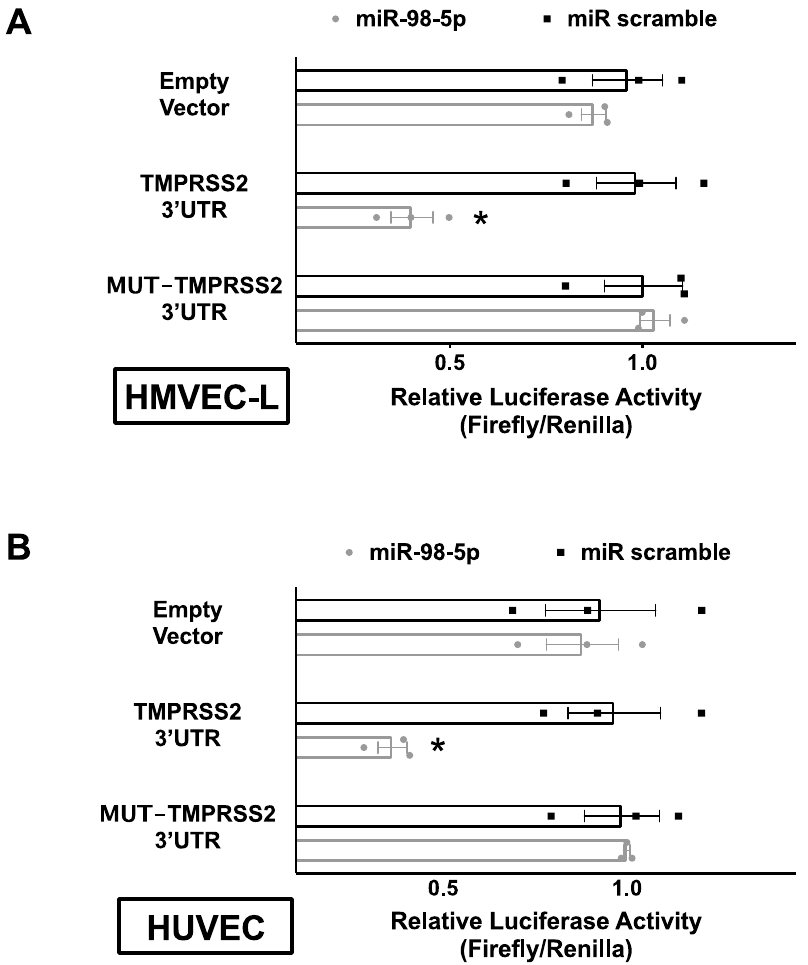
Figure 2. Validation of TMPRSS2 targeting by miR-98-5p. Luciferase activity was measured in adult human lung microvascular endothelial cells (HMVEC-L) ( A ) and human umbilical vein endothelial cells (HUVEC) ( B ) 48 h after transfection, using the vector without TMPRSS2 3 ′ -UTR (empty vector), the vector containing the wild-type TMPRSS2 3 ′ -UTR, and the vector containing a mutated TMPRSS2 3 ′ -UTR (TMPRSS2 MUT); a non-targeting miRNA (miR scramble) has been employed as further control. Means ± S.E.M. are shown alongside actual values; * p < 0.05.